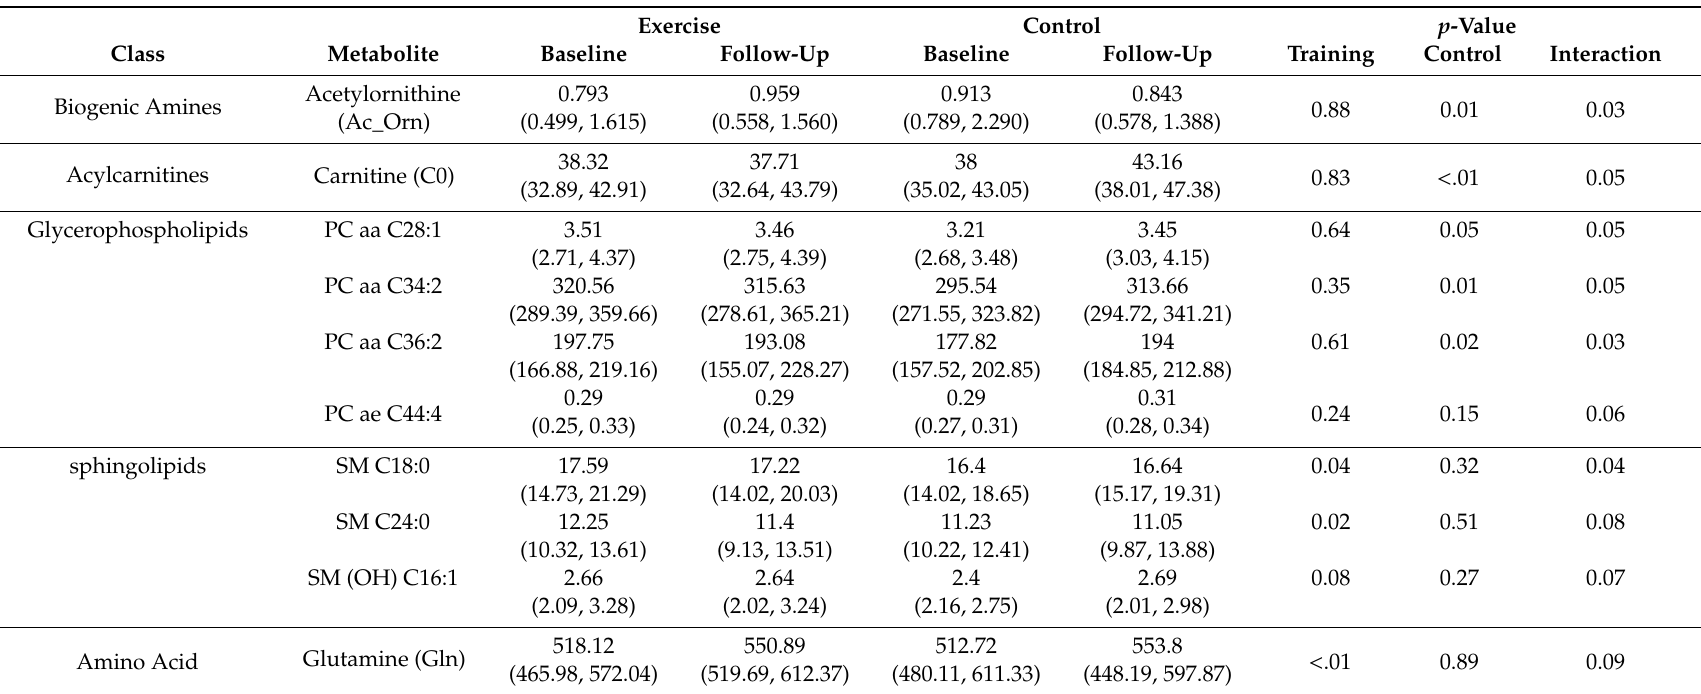
Table 2. Metabolic changes from baseline to